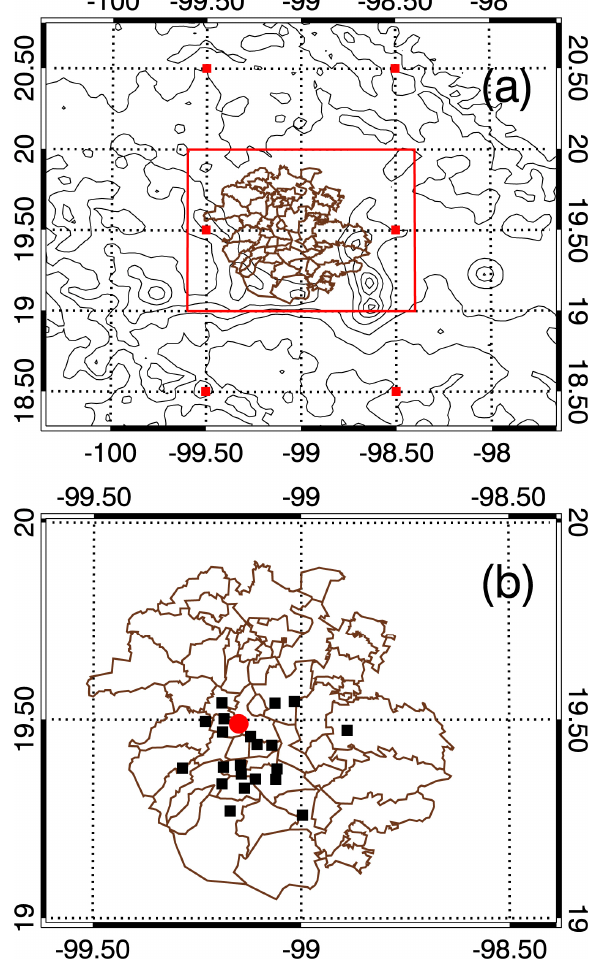
Fig. 1. WRF-CHEM simulation domain. Black filled squares rep- resent the RAMA (Mexico City Ambient Air Monitoring Network) sites. The red filled circle represents the T0 supersite and the red filled squares denote the area with MODIS